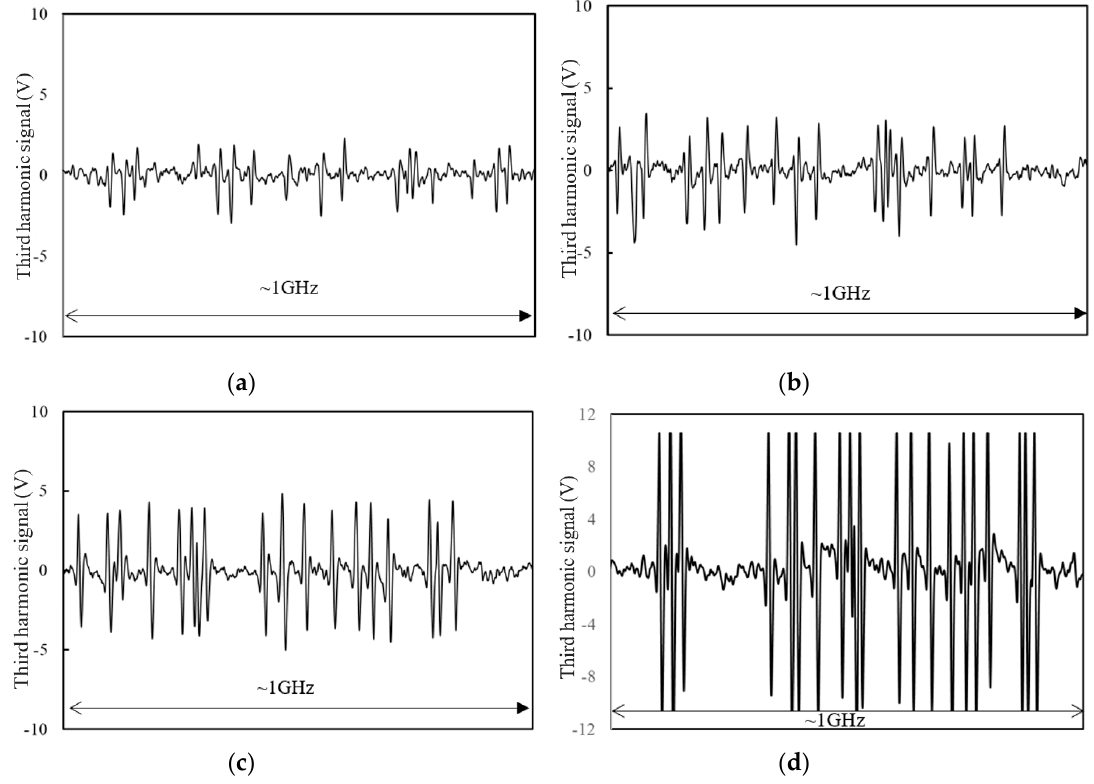
Figure 4. Hyperfine spectrum of the transition 6–3, P(33) of 127 I 2 obtained by third-harmonic detection with a modulation frequency of 1 MHz: ( a ) a modulation excursion of 10 MHz; ( b ) a modulation excursion of 15 MHz; ( c ) a modulation excursion of 20 MHz; ( d ) a modulation excursion of 25 MHz. Appl. Sci. 2020 , 10 , x FOR PEER REVIEW